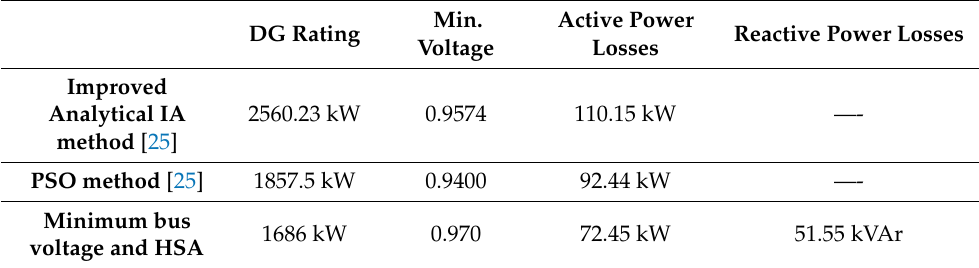
Figure 13. The voltage profile at 100% loading condition. Table 10. Comparison between the proposed siting and siting of DGs (min. bus voltage + HSA) with other reported techniques in the literature (PSO and IA).